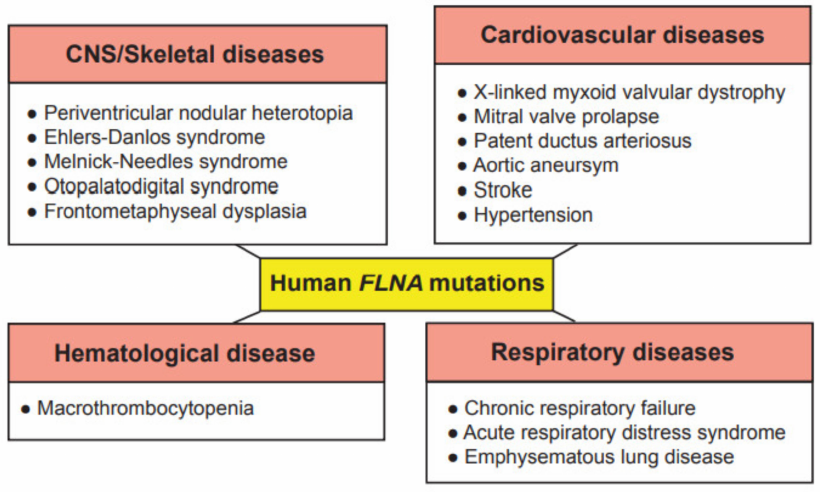
Figure 2. Genetic diseases associated with mutations in the human FLNA gene. These genetic diseases are grouped into central nervous system (CNS)/skeletal, cardiovascular, hematological and respiratory